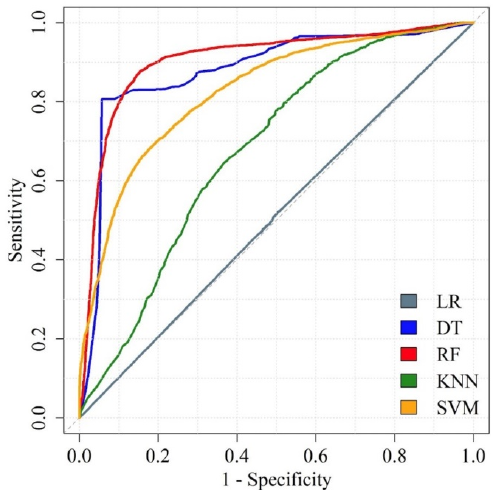
Figure 8. Diagnostic performance of the models by ROC curve. ROC curves of the five predictive models. LR: logistic regression; DT: decision tree; RF: random forest; KNN: k-nearest neighbor; SVM: support vector machine.